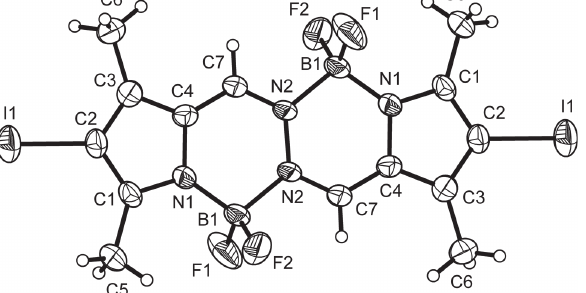
Table 1: Data collection and handling.